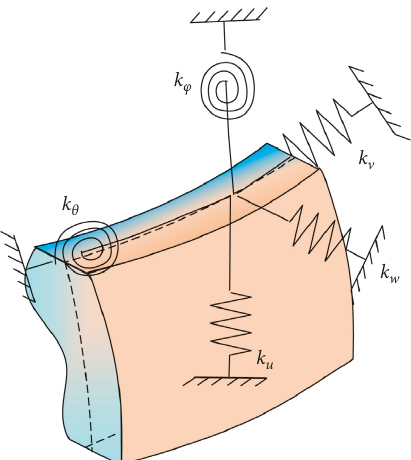
Figure 2: The partial view of FG spherical shell with